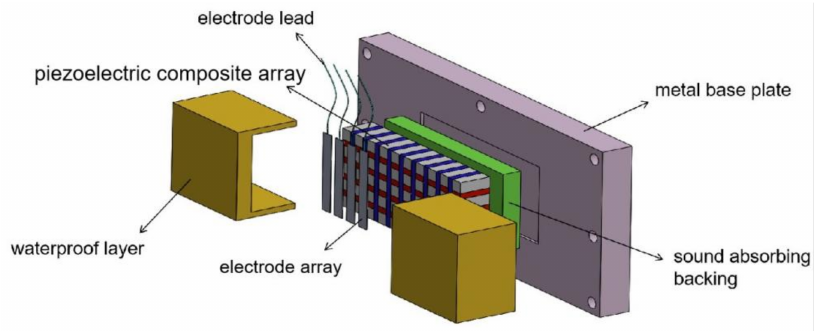
Figure 2. Structural design of the 1–3 piezoelectric composite planar array